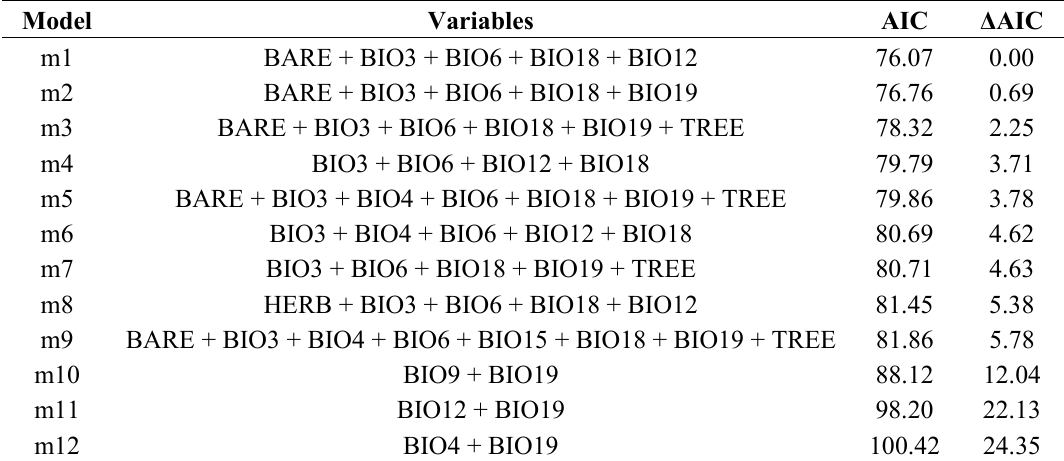
Table 2. Multivariate binomial GLM models for HPS by Andes virus occurrence in southern Argentina. Model